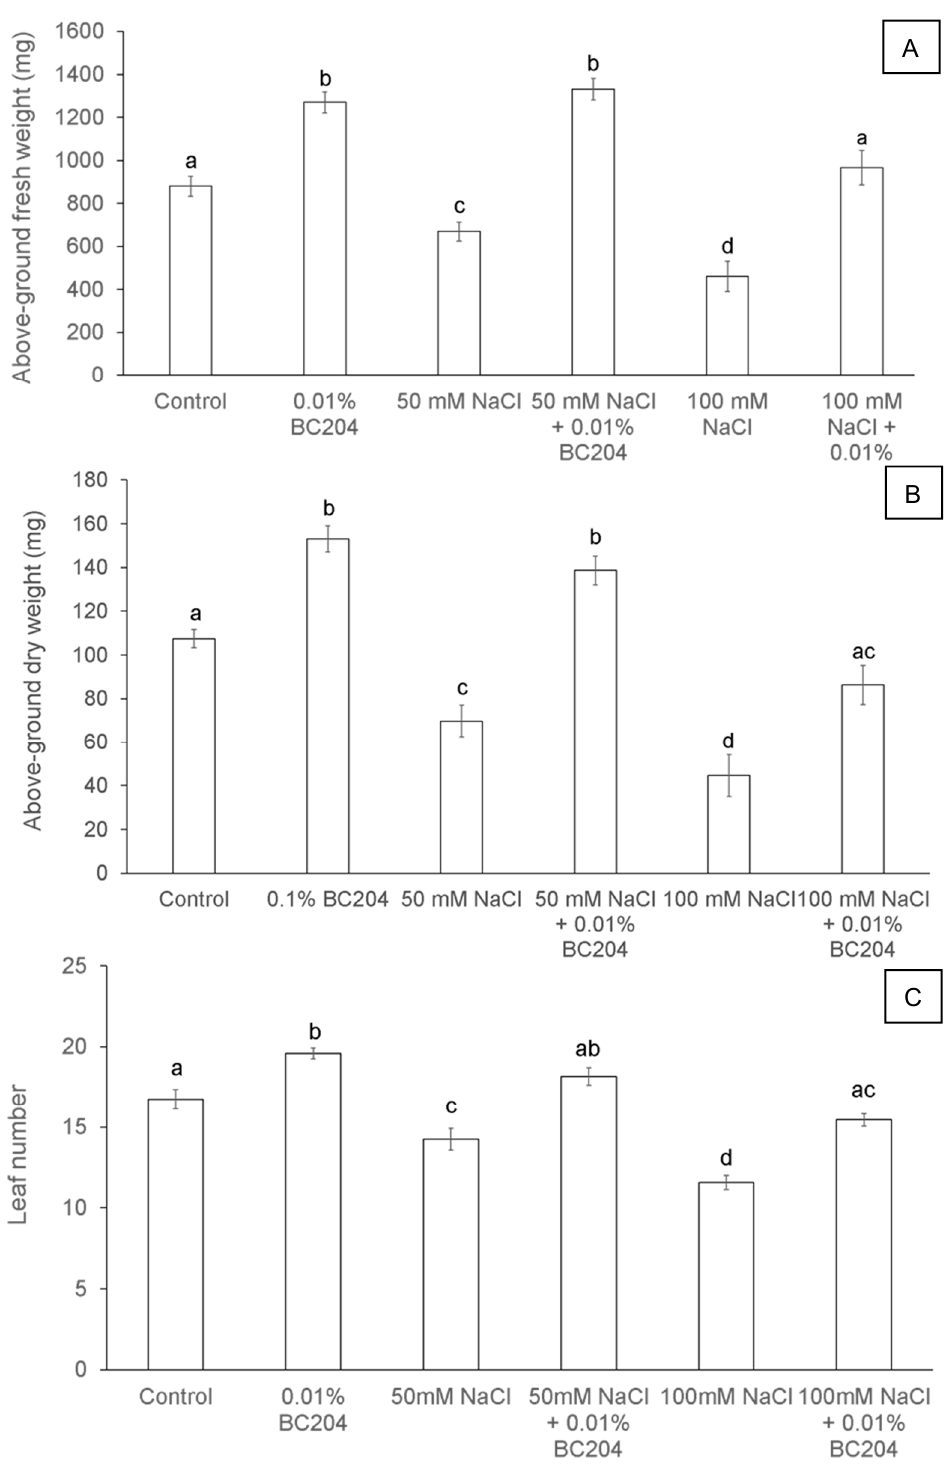
Figure 2. Above-ground fresh ( A ) and dry ( B ) biomass production and total leaf number ( C ) of Arabidopsis thaliana plants treated with BC204 and two different concentrations of NaCl. Bars represent the mean of 20 replicates ( n = 20) ± standard error. Different letters indicate values that were determined by one-way ANOVA with Fisher’s LSD post-hoc test to be significantly different ( p < 0.05) from the control.